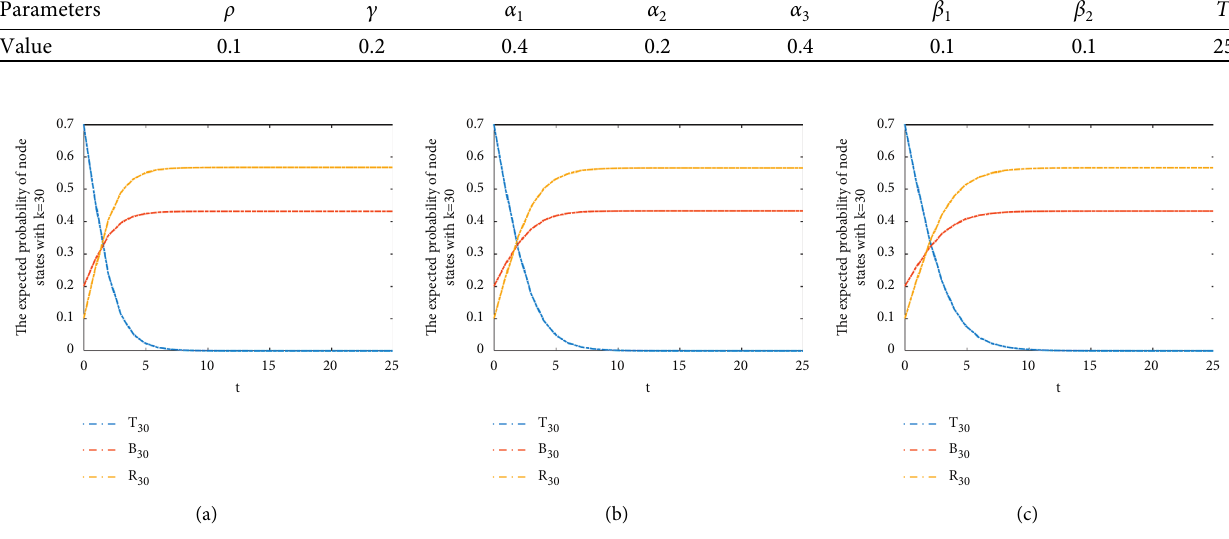
Figure 4: (a) Facebook network, (b) e-mail network, and (c) Twitter network.